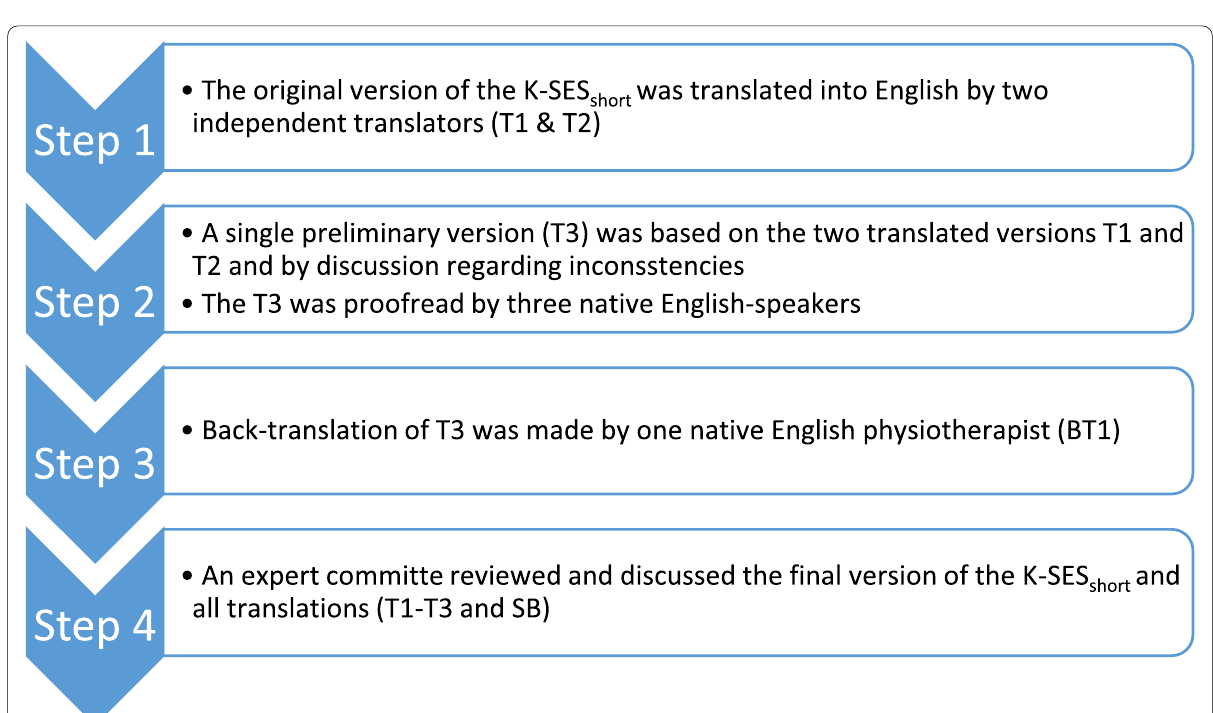
Fig. 1 Illustration of the translation and cross-cultural adaptation process of the 18-item version of the Knee Self-Efficacy Scale (K-SES 18